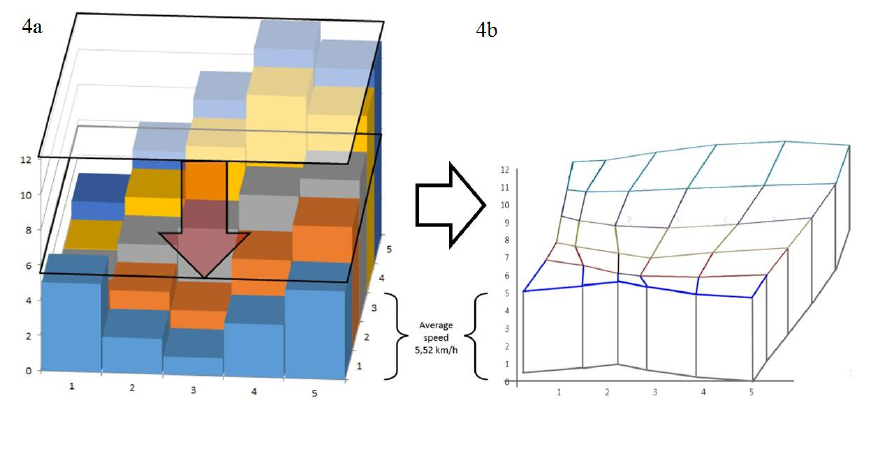
Fig. 4. Three-dimensional matrix anamorphosis of cross-country rate matrix.